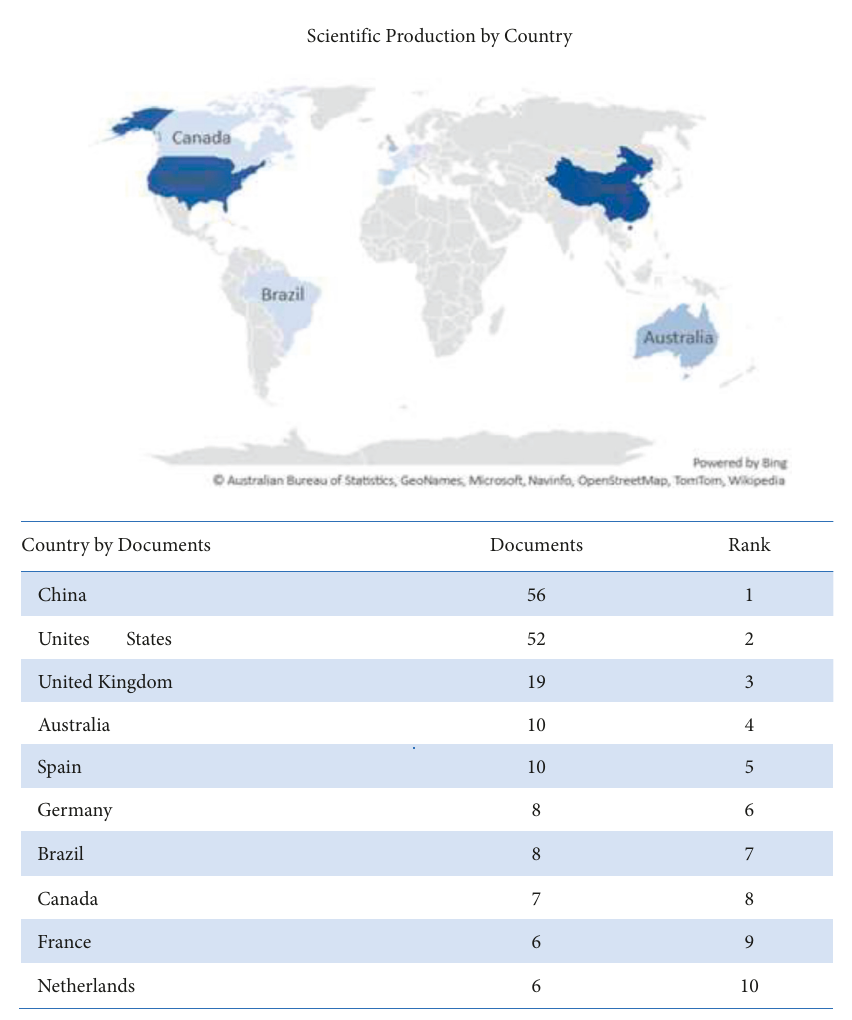
Figure 4: Documents by